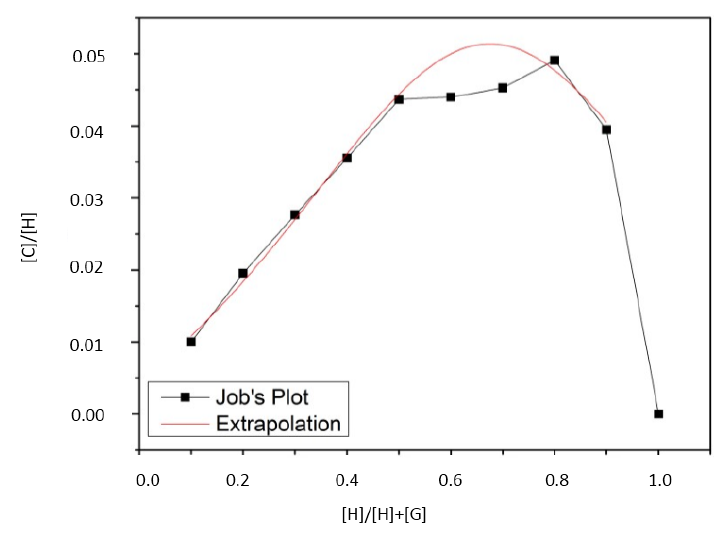
Figure A1. Modified Job’s plot of host–guest complexation using 1